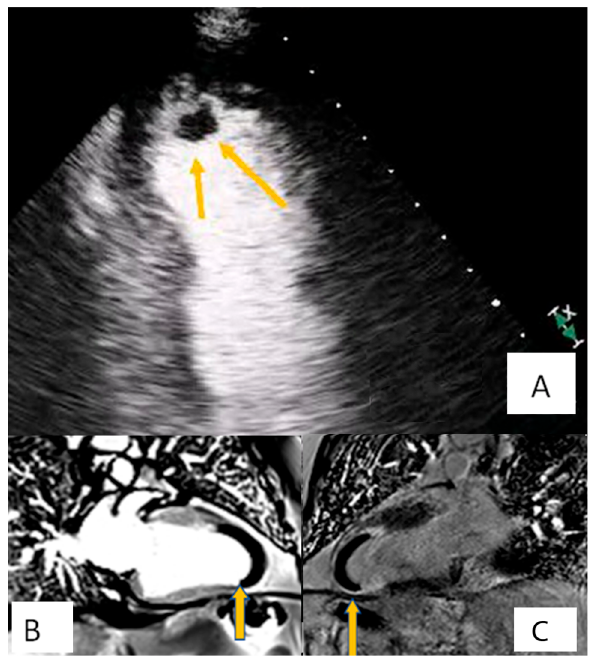
Figure 2. Patient presenting with anterior myocardial infarction the second day after primary percutaneous transluminar coronary angioplasty (PTCA). Apical 4-chamber view. ( A ) A lesion is depicted on cardiac apex (yellow arrows), mobile, without vasculature, findings compatible with clot. ( B,C ) Large laminar LV thrombus adjacent to an area of apical myocardial infarction. Two chambers EGE (image ( B )) and LGE (image ( C )) respectively.